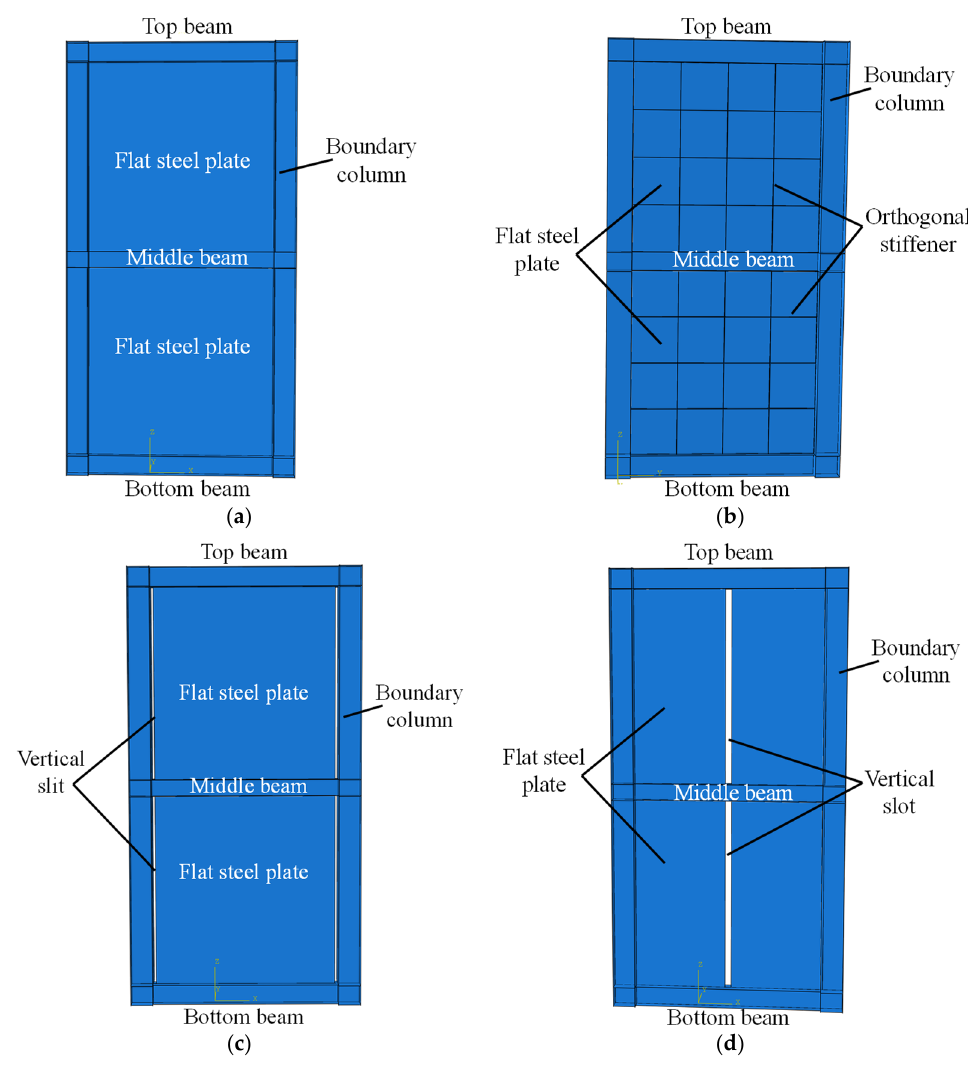
Figure 1. Diagrams of specimens: ( a ) FSPSW; ( b ) OSPSW; ( c ) BSPSW; ( d ) VSSPSW. The detailed dimensions and profiles of the four kinds of SPSW specimens are pre- sented in Figure 2. The boundary conditions of FEM models for specimens are shown in Figure 3, and the boundary condition of flat steel plates is that the upper and lower sides are only connected with the frame beam. The constitutive relation of the material is shown in Figure 4, and σ y is the yield strength, σ u is the ultimate strength, σ st is 85% of σ u . Modeling with S4R four-node shell elements, the “Merge” command is used to simulate the connection between the beam and frame column, and the “Tie” command is applied to simulate the infilled steel plate welded to the beam. The element size of the infilled steel plate is 30 mm × 30 mm, and the element size of the boundary frame is 35 mm × 35 mm. The vertical load, such as gravity, is simulated with an axial force of 2500 kN, and the horizontal load is applied at a coupling point consisting of the top of the boundary column until the specimen is damaged.